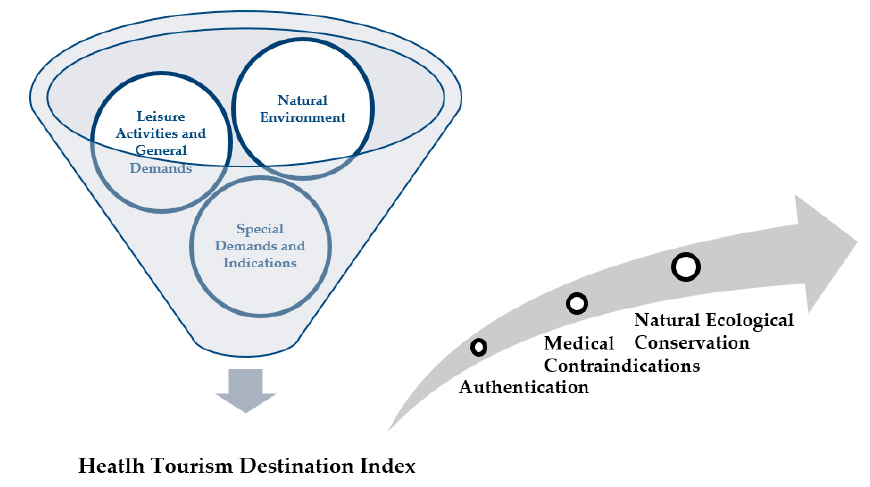
Figure 2. Development of a health tourism destination index.